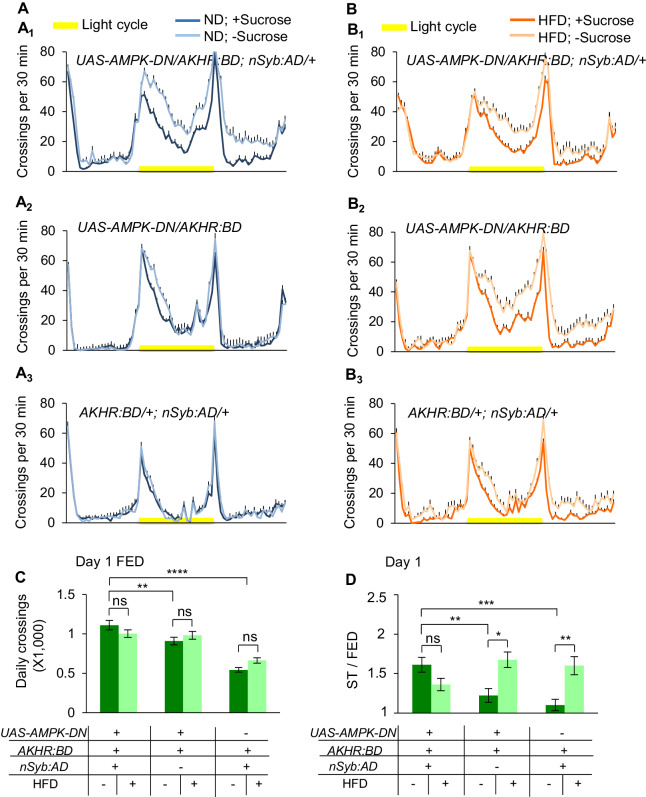
Suppressing AMPK signaling in AKHR+ neurons promotesstarvation-induced hyperactivity.(A–B) Midline crossing activity of indicated genotypes and diet treatments assayed in the presence or absence of 5% sucrose (n = 30–59). (C) Average daily midline crossing activity of fed flies assayed in A-B. (D) Starvation-induced hyperactivity of flies assayed in A-B. ns, p>0.05; *p<0.05; **p<0.01; ****p<0.0001. Student’s t-test, one-way and two-way ANOVA followed by post hoc test with Bonferroni correction were used for multiple comparisons when applicable.